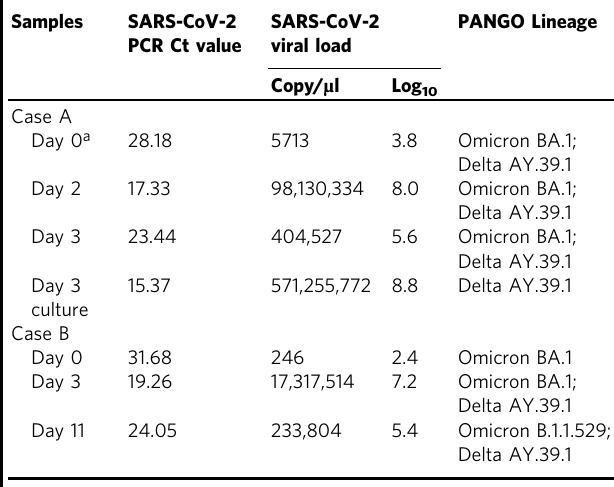
Table 1 SARS-CoV-2 yield in Cases A and